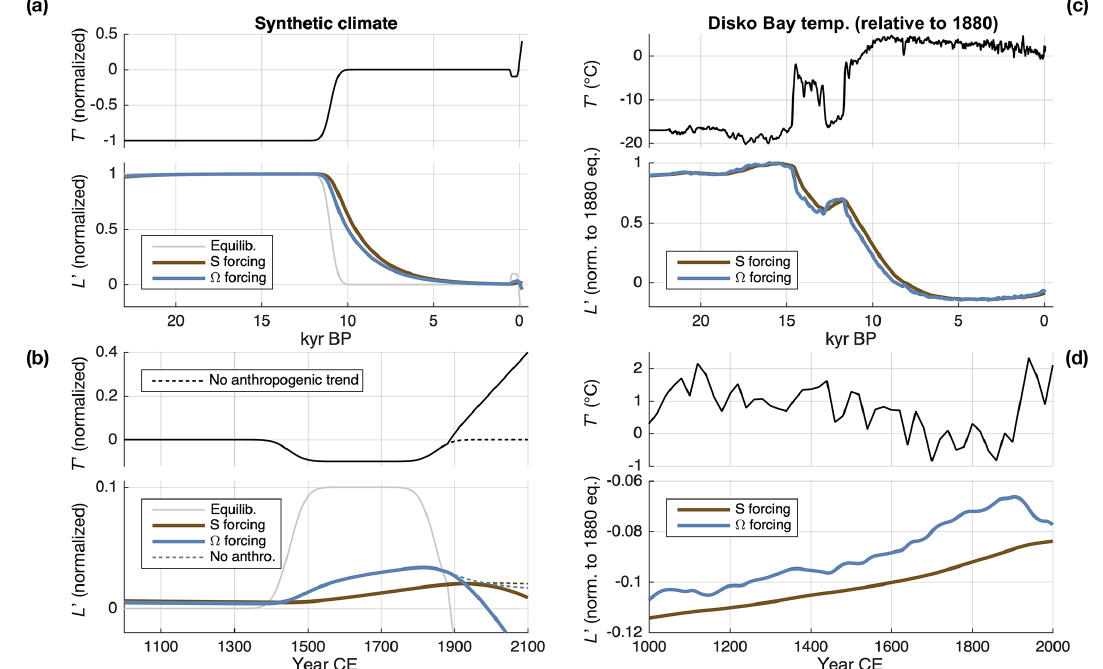
Figure 7. Response to long-term climate variations. (a) An idealized climate scenario representing the last deglaciation, Little Ice Age (LIA), and anthropogenic forcing (black line). Normalized length responses of the linear model are shown for forcing applied via S (brown) and (cid:127) (blue). The length at which the glacier would remain in equilibrium with climate is shown for reference (gray). (b) As for (a) but zoomed into the last 1000yr. (cid:127) forcing produces a much larger response on multicentury timescales, but the glacier does not reach equilibrium with the LIA in either case. (c) A more realistic forcing time series, based on reconstructed atmospheric temperatures for Disko Bay (black line; Buizert et al., 2018). Normalized length responses are again shown for both forcing types, which yield similar responses on multimillennial timescales. (d) As for (c) but zoomed into the last 1000yr. Again, the LIA is expressed to a greater degree through ocean forcing. Note also the long-term advance driven by gradual cooling over the last several